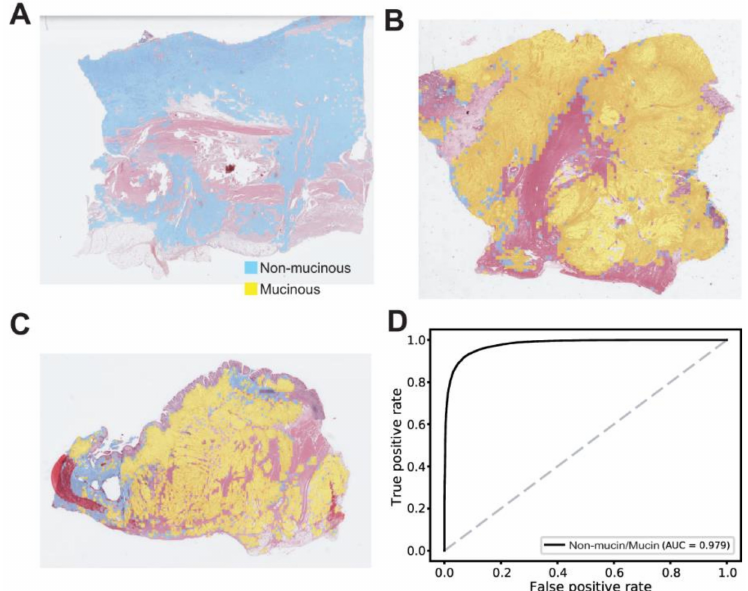
Figure 3. Results for the non-mucinous/mucinous classification on the TCGA-STAD dataset. ( A ) A representative heatmap overlaid on a tissue slide image demonstrating a mainly non-mucinous tumor tissue. ( B ) A representative heatmap overlaid on a tissue slide image demonstrating a mainly mucinous tumor tissue. ( C ) A representative heatmap overlaid on a tissue slide image demonstrating a relatively mixed tumor tissue. ( D ) The patch-level area under the curve for the receiver operating characteristic curve of the non-mucinous/mucinous